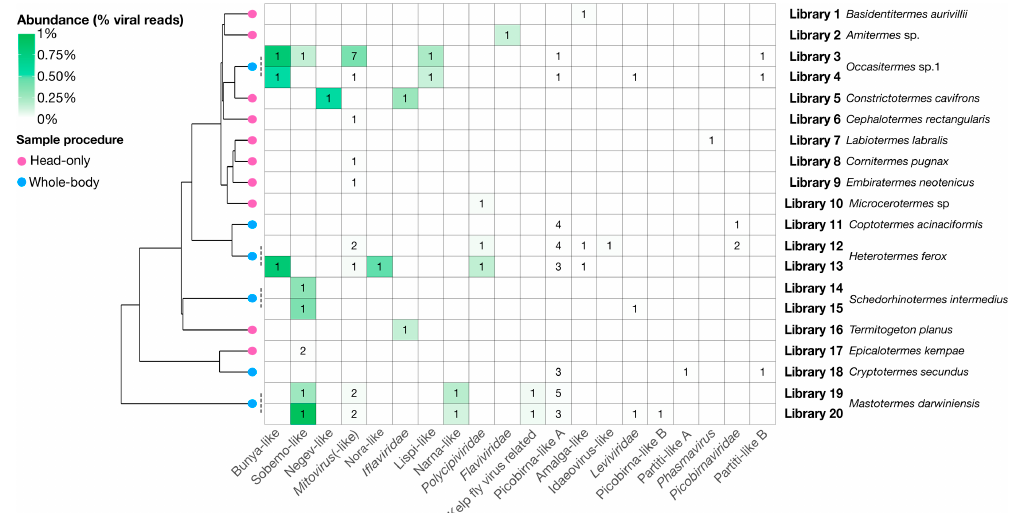
Figure 9. Heatmap showing number of virus genomes and their relative abundance in each library. Virus clades are shown on the x-axis by decreasing total abundance, libraries are given on the right y-axis ordered by the phylogenetic relationships of the termites in each library. The abundance, as a percentage of the total reads, of each genome is presented as a heat map while the number of genomes found for each group is labeled for each cell. The schematic phylogenetic tree on the left is adapted from Bucek et al. [7] and represents phylogenetic relationships between termites associated with each library. Tip nodes on this tree are colored by procedure used to collect termites and process them to libraries: Blue nodes represent the “whole-body” procedure, while pink nodes represent the “head-only” procedure.